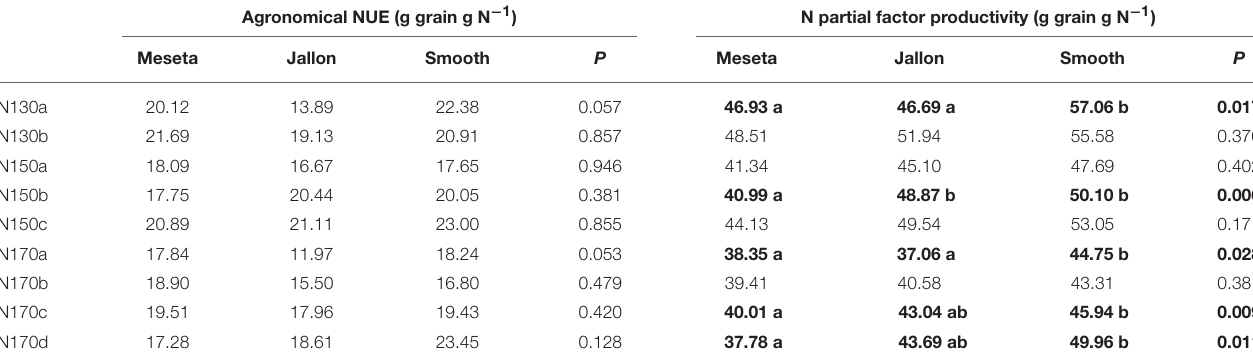
TABLE 2 | Agronomical nitrogen use efficiency (NUE) and N partial factor productivity according to the 10N application regimens as detailed in Table 1